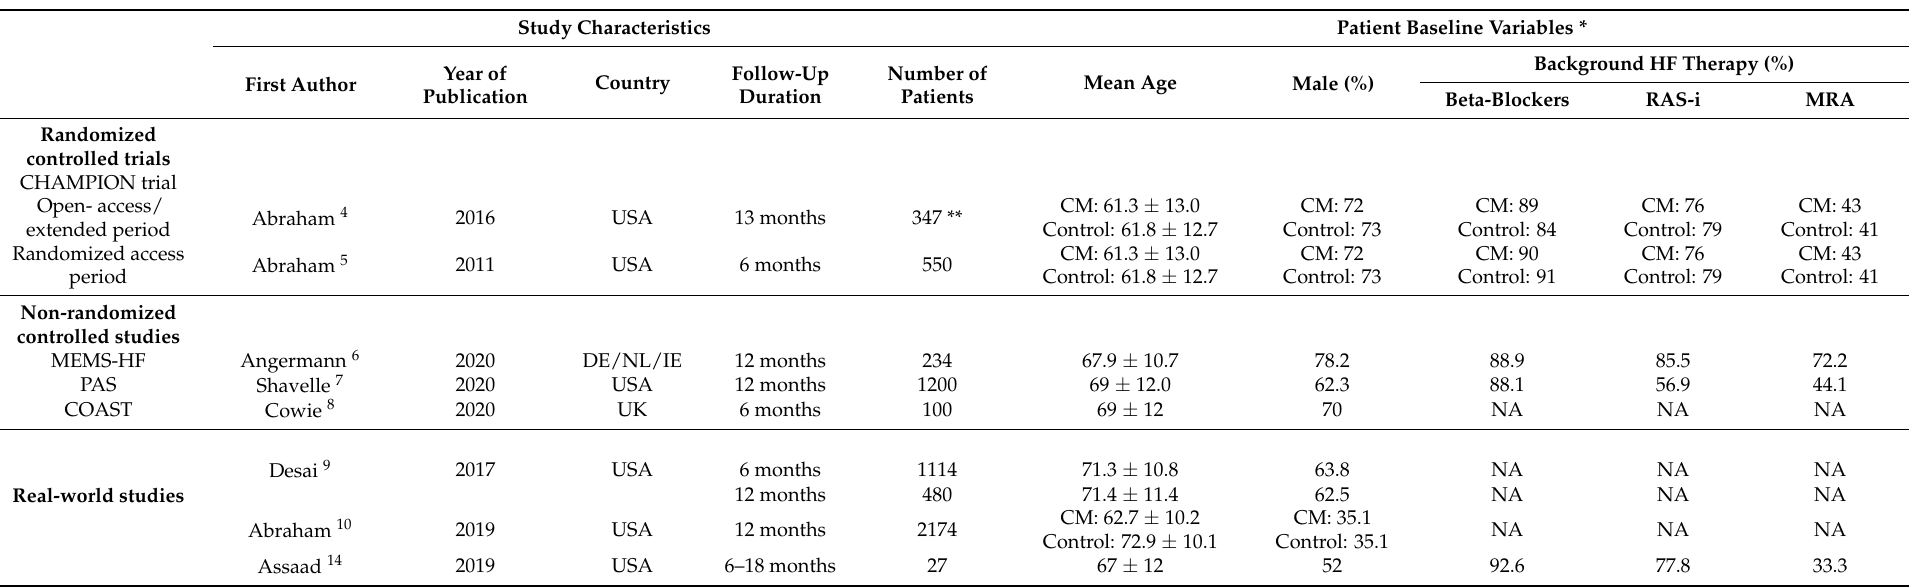
Table 1. Overview of study characteristics and patient baseline variables of CardioMEMS